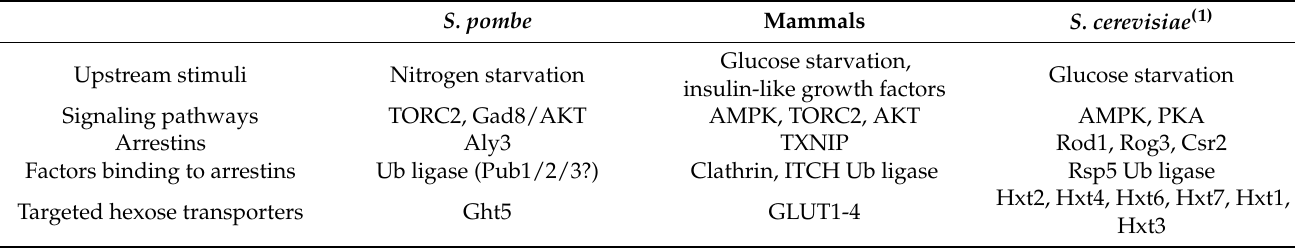
Figure 1. The TORC2-Gad8/AKT signaling pathway ensures cell-surface localization of the S. pombe hexose transporter, Ght5. Table 1. Upstream stimuli and signaling cascades that control subcellular localization of hexose transporters in model